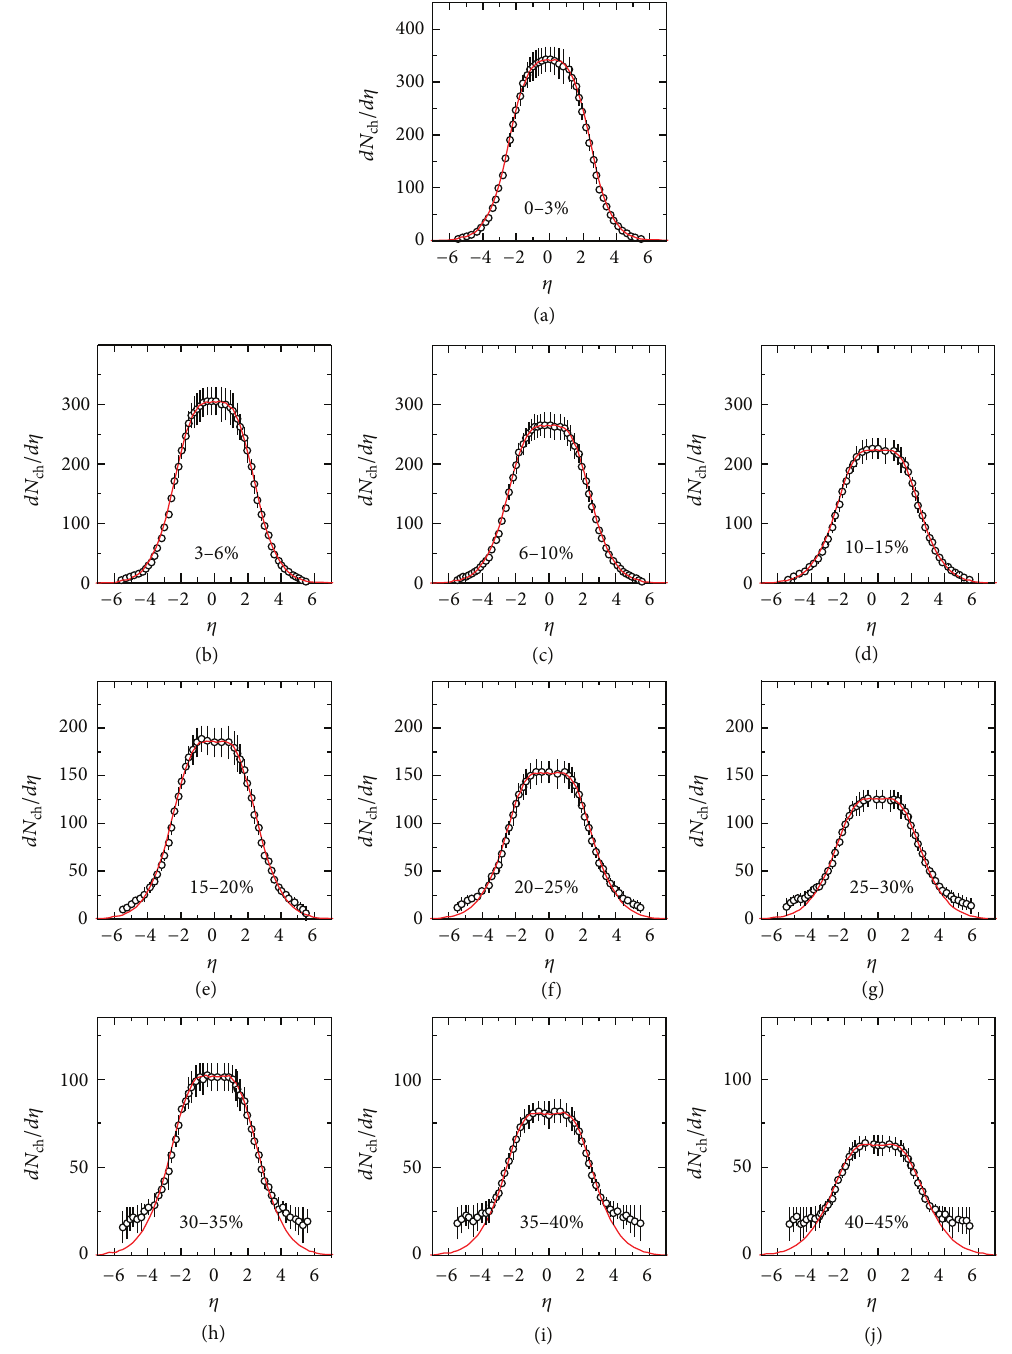
Figure 1: Pseudorapidity distributions of charged particles produced in Au-Au collisions at √𝑠 NN = 19.6 GeV with different centrality percentages. The circles and curves represent the experimental data quoted in [22] and our calculated results, respectively. In the calculation, spectator contributions in Figures 1(e)–1(j) are not counted, and there is no spectator being expected in Figures